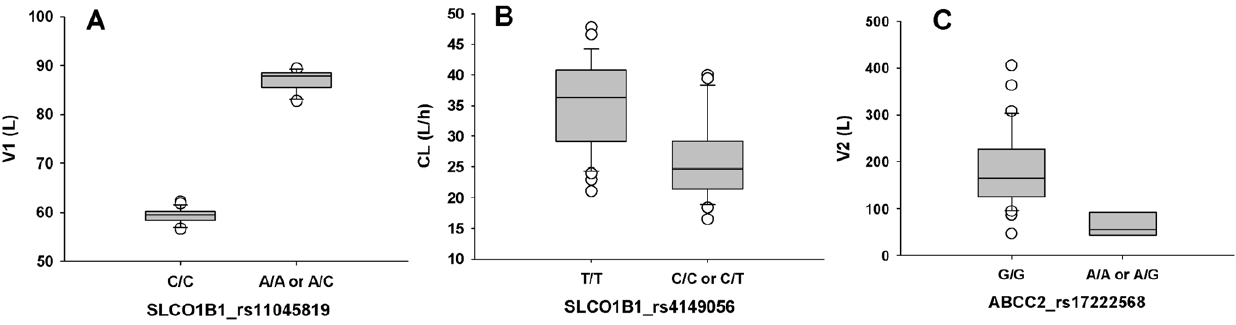
Figure 2. Relationships between the most significant genetic covariates and estimates for each of the 4 PK parameters from univariate analysis in the phase I dataset. Box plots represent the scatter of individual V1 estimates vs. SLCO1B1 rs11045819 (Panel A), CL estimates vs. SLCO1B1 rs4149056 (Panel B), and V2 estimates vs. ABCC2 rs8187710 (Panel C). For rs11045819, data is displayed with V1 estimates using BSV on